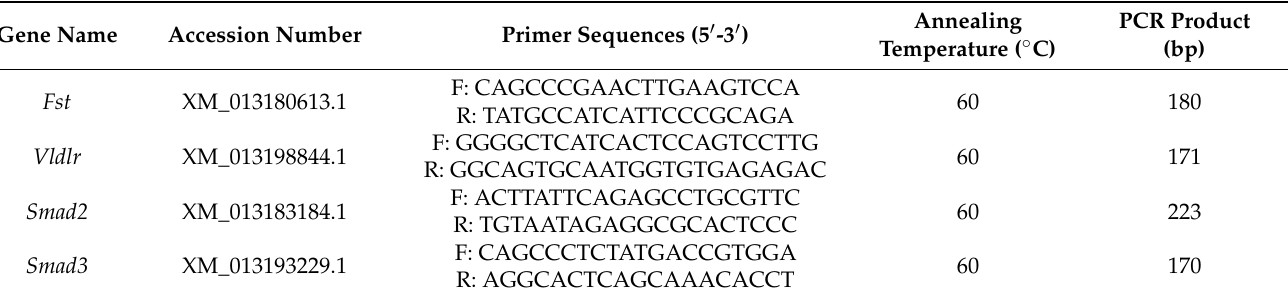
Table 1. Primers used in the real-time PCR assay of